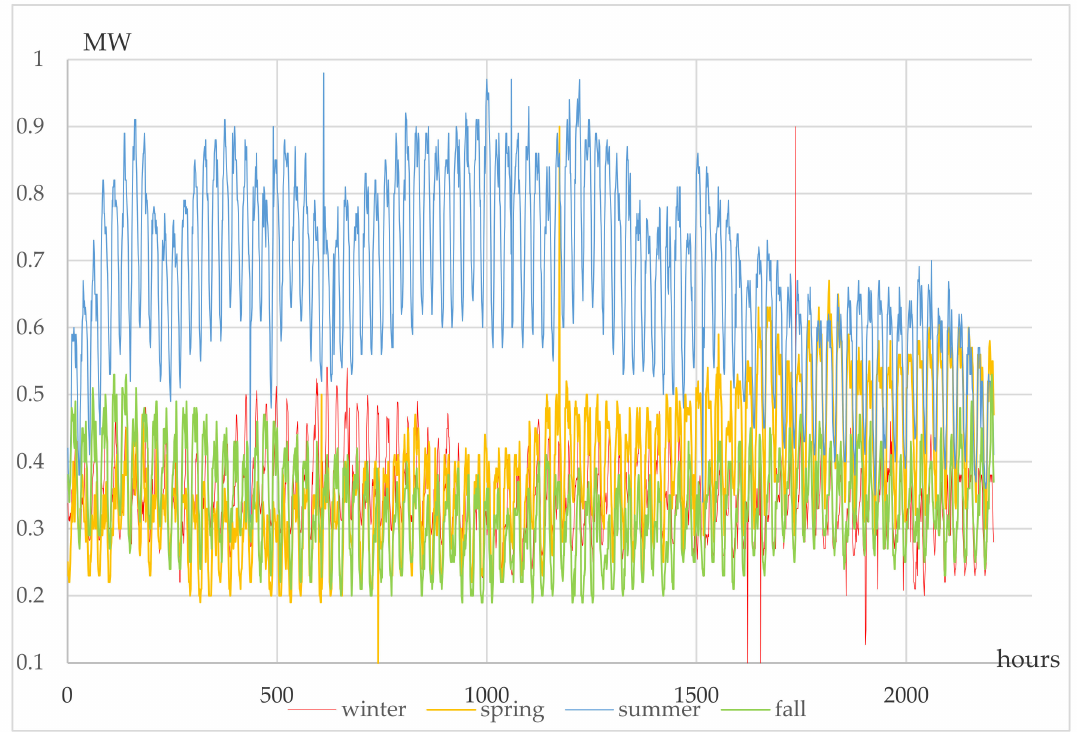
Figure 1. Hourly electricity demand for the winter, spring, summer and fall months for